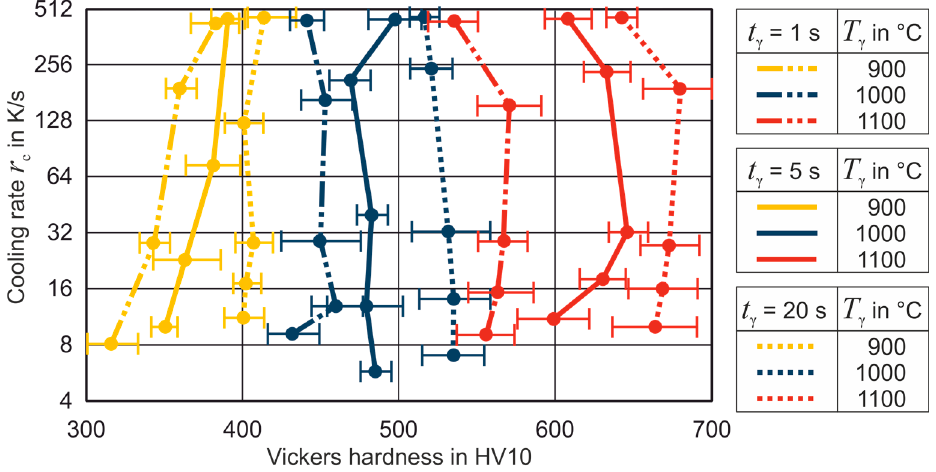
Figure 4. Hardness of X46Cr13 determined from the quenching tests with variation of the austenitizing temperature T γ , dwell time t γ , and cooling rate r c .